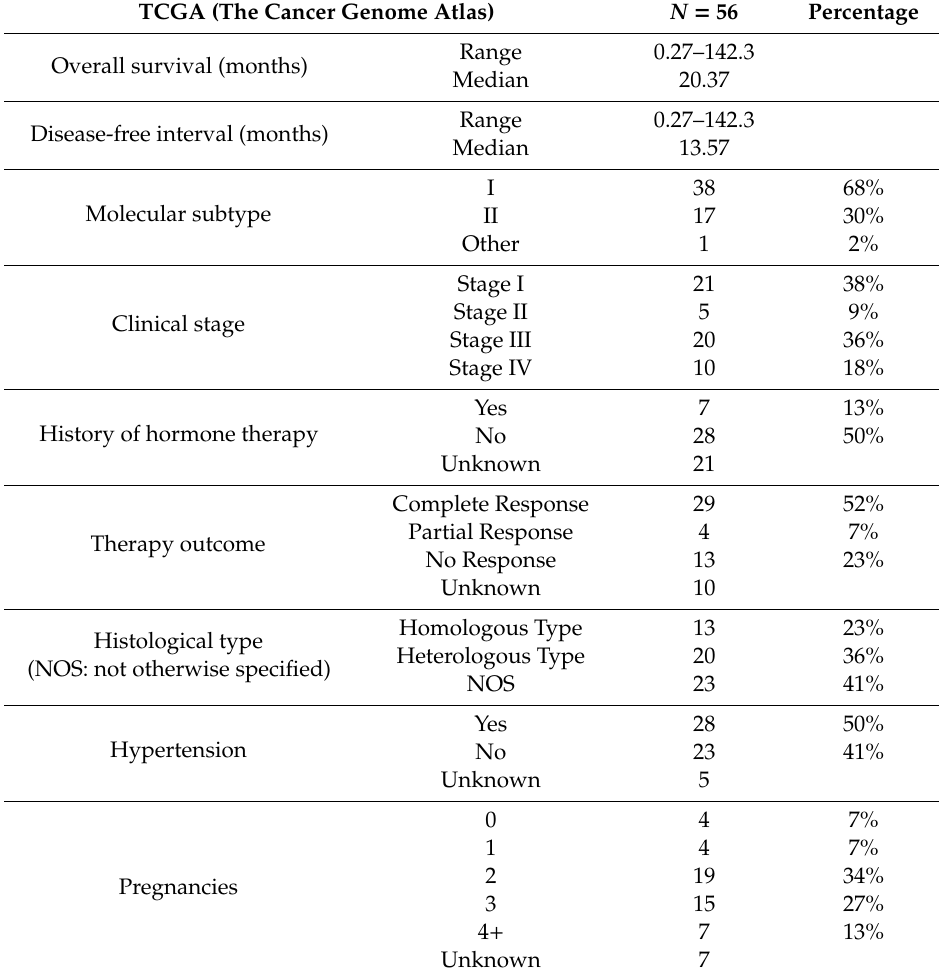
Table 1. Clinicopathologic characteristics ( N =